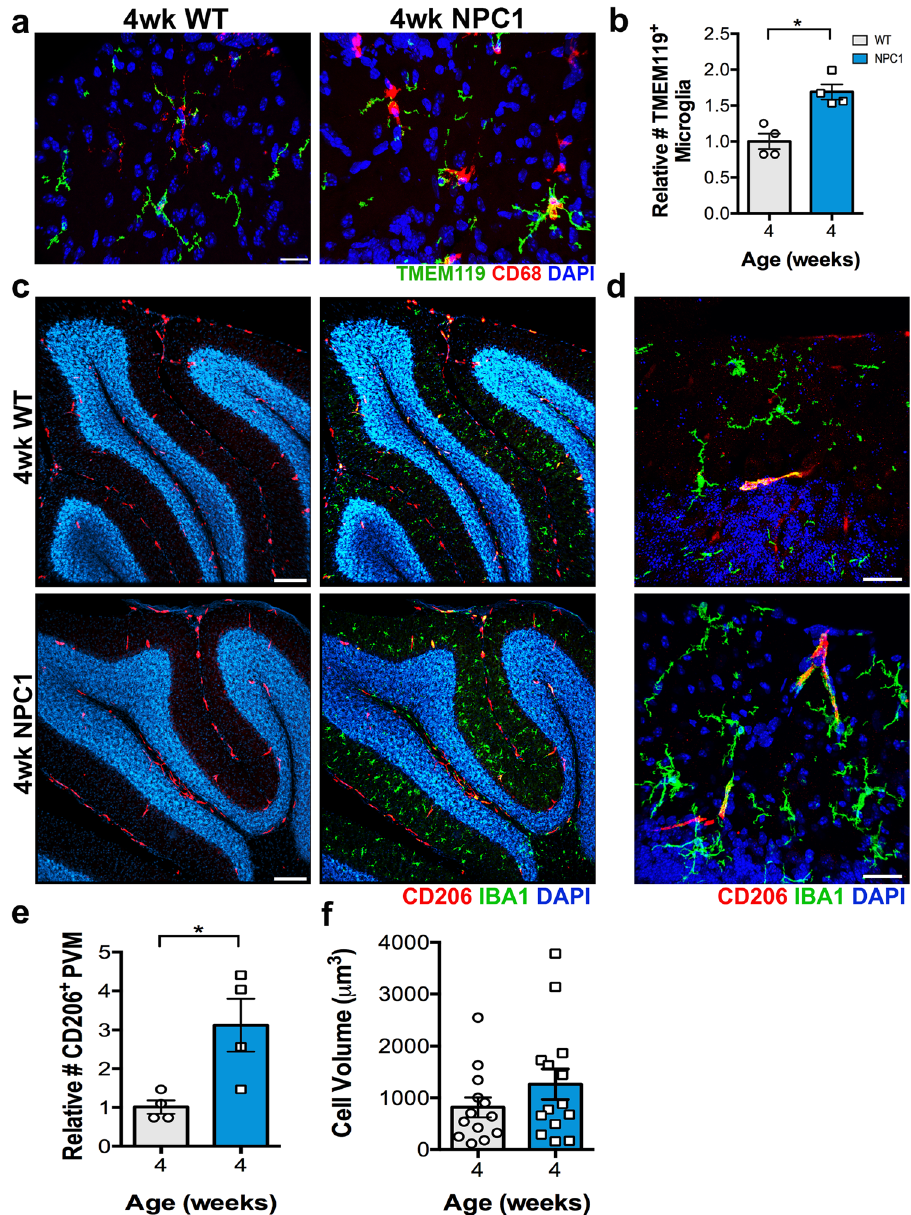
Figure 4. In Npc1 nmf164 mice, the densities of resident microglia and resident perivascular macrophages are increased at early stage of NPC disease. ( a ) Resident microglia at 4 weeks of age were immunopositive for TMEM119 (green) and CD68 (red) at the ML in WT and Npc1 nmf164 mice. ( b ) The number of TMEM119 + microglia was almost two times higher in Npc1 nmf164 mice than in WT mice. ( c ) Low magnified images showing the scattered number and distribution of CD206 + resident perivascular macrophages in the cerebella of 4 weeks old WT and Npc1 nmf164 mice. Not all the cells were IBA1 + . The majority of CD206 + cells were observed at the meninges and at the white matter region of the cerebellum. ( d ) High magnified images of the ML showing perivascular macrophages that are positive for CD206 and IBA1 immunostaining at 4 weeks of age in WT and Npc1 nmf164 mice. ( e ) Quantitative analysis of CD206/IBA1 + perivascular macrophages showed a significant increase in the ML of 4 weeks Npc1 nmf164 mice. ( f ) No significant changes in the cell volume of CD206 cells between WT and Npc1 nmf164 mice. Data are presented as mean ± SEM, n = 4 per group, * P < 0.05. Scale